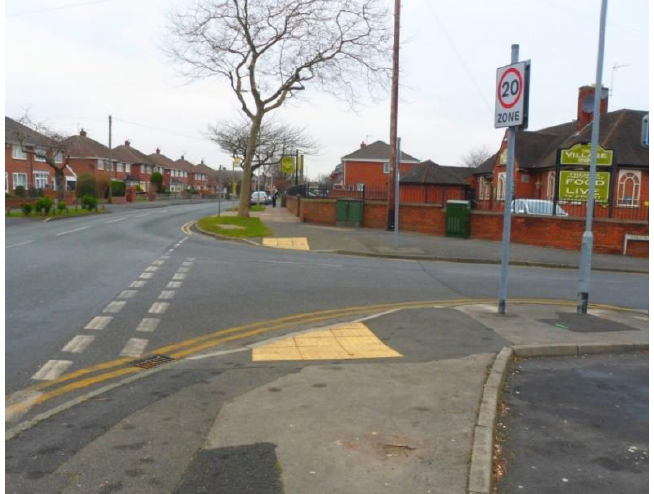
Figure 10. Example of sidewalks promoting respect and social inclusion (P23) (Road, Liverpool).